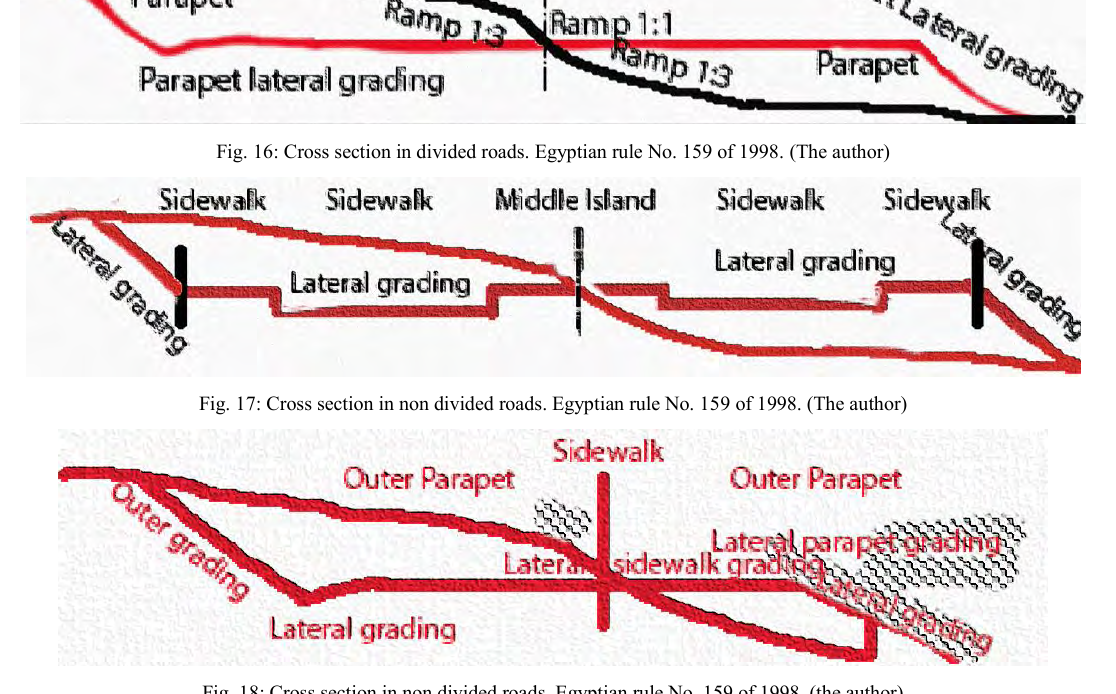
Fig. 18: Cross section in non divided roads. Egyptian rule No. 159 of 1998. (the author)